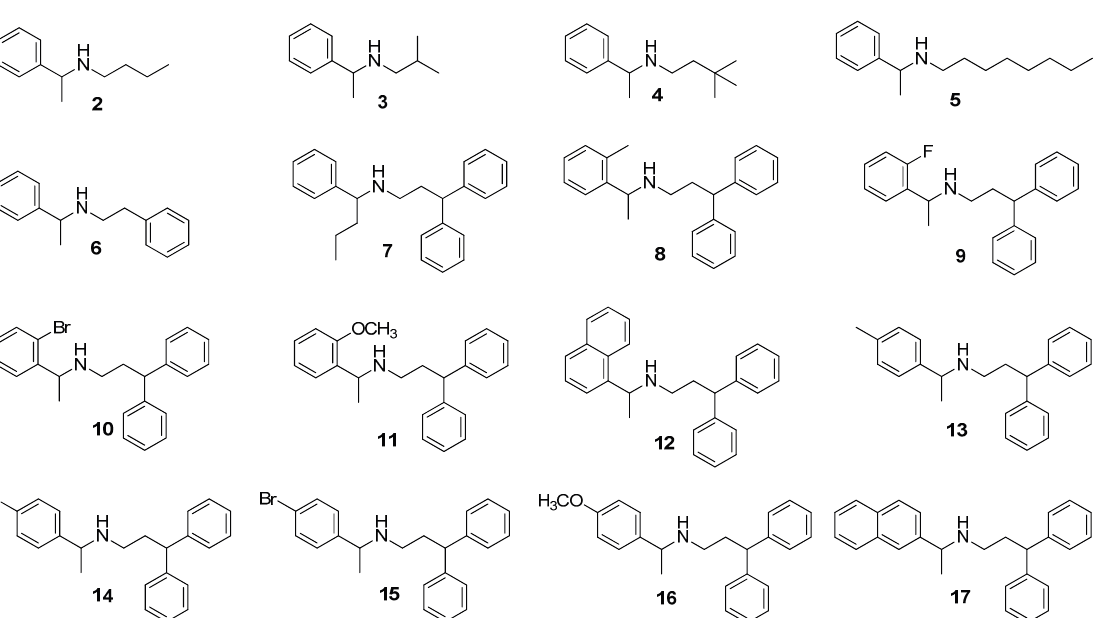
Figure 2. Structures of fendiline analogues ( 2 – 17